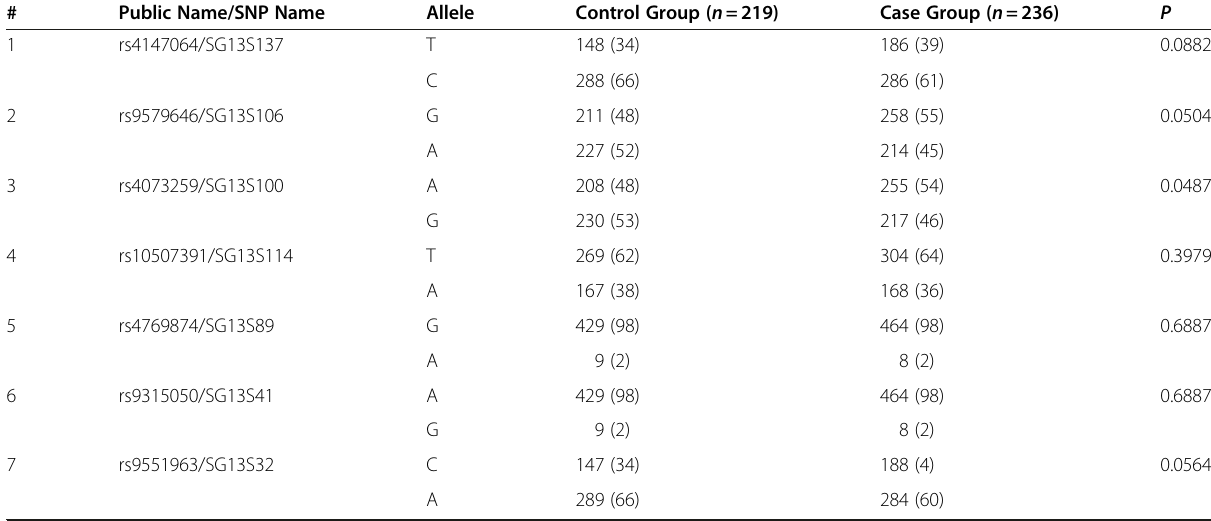
Data are presented as numbers (percentages).